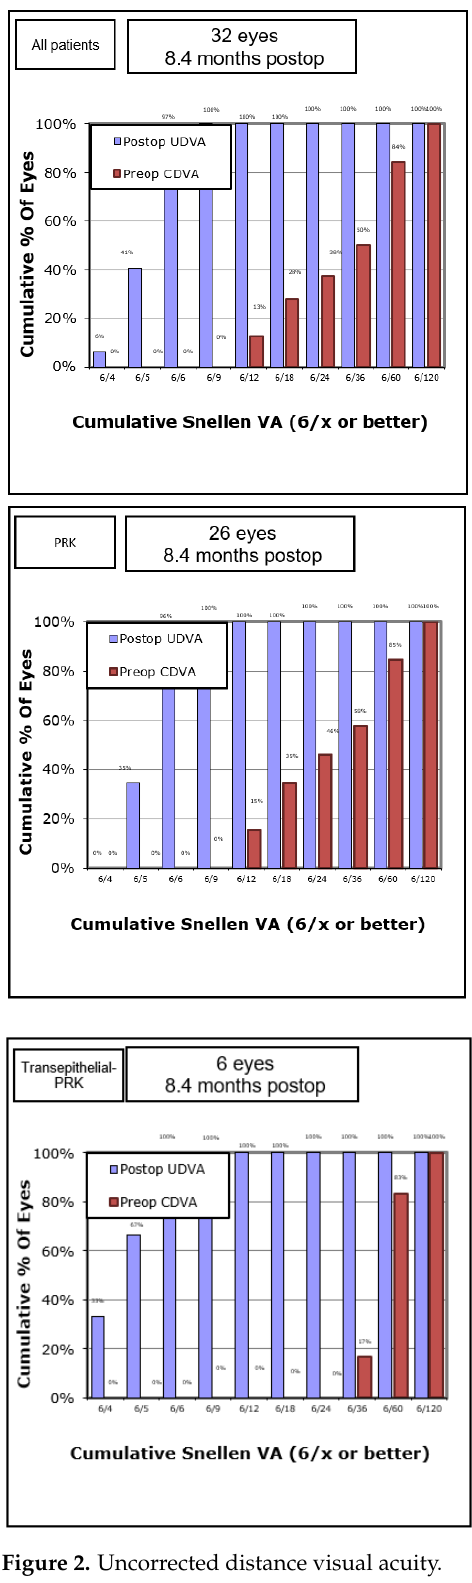
Figure 1. Percent of participants having a UCVA of at least 6/6, 6/5, and 6/4.